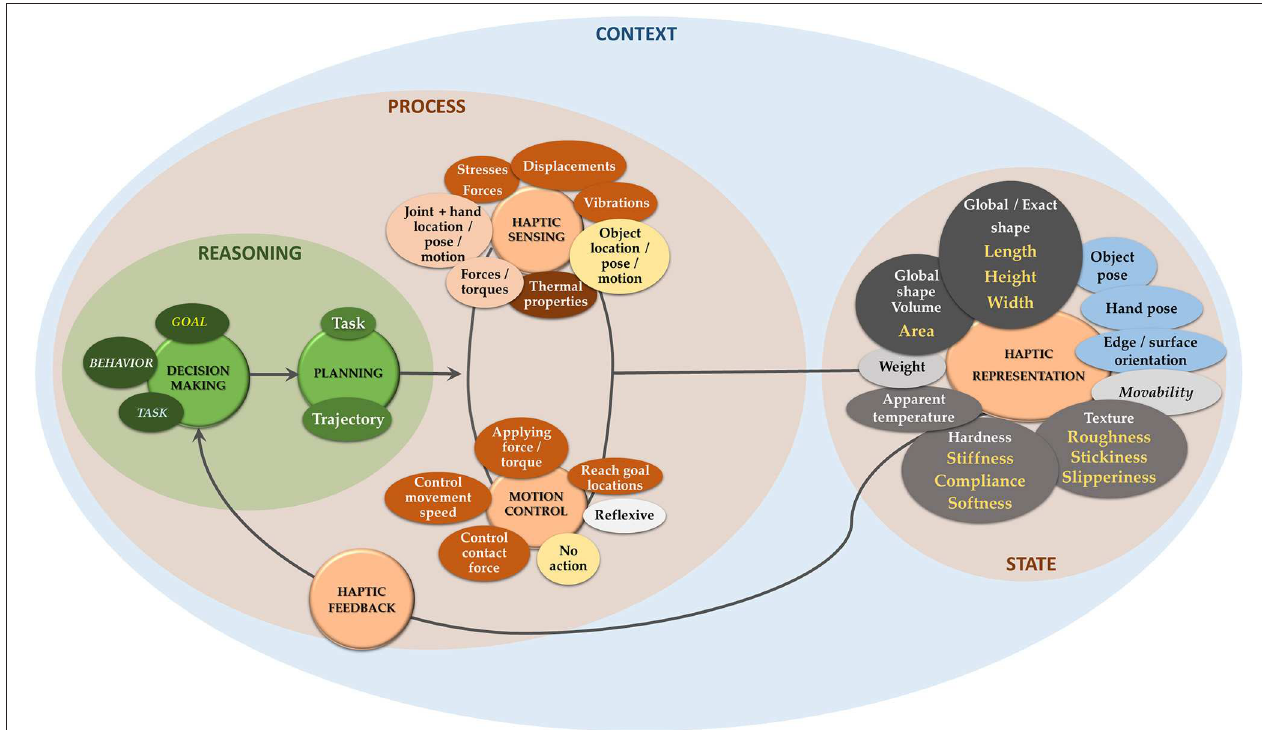
FIGURE 3 | Overview of the proposed taxonomy. The state includes all categories described in section 2.1. Gray blocks among haptic features are related to the object: darkest are geometric, lighter is hybrid and mid gray blocks are related to material properties. For all gray blocks, top features belong to the taxonomy from Lederman and Klatzky (2009), at the bottom (yellow) are same category features as commonly found in the Robotics literature. Movability is added among gray blocks. Light blue blocks relate to spatial information. The process step includes both a first phase of choice, planning and triggering motion (corresponding to action planning and selection in humans), and a dynamic phase including all adjustments during sensorimotor control driven by sensory feedback. Blocks belonging to Haptic Sensing reproduce information given by all sensor categories of Figure 2 : exteroceptive-mechanical (orange), exteroceptive-thermal (brown), exteroceptive-proximity (yellow), proprioceptive-dynamics/kinematics (pink). Motion Control first guides motion unfolding to reach goal locations in space. Reactive (orange) and reflexive (white) actions have been included in the motion control scheme for the sake of completeness. “No action” includes receptive mode through whiskers and